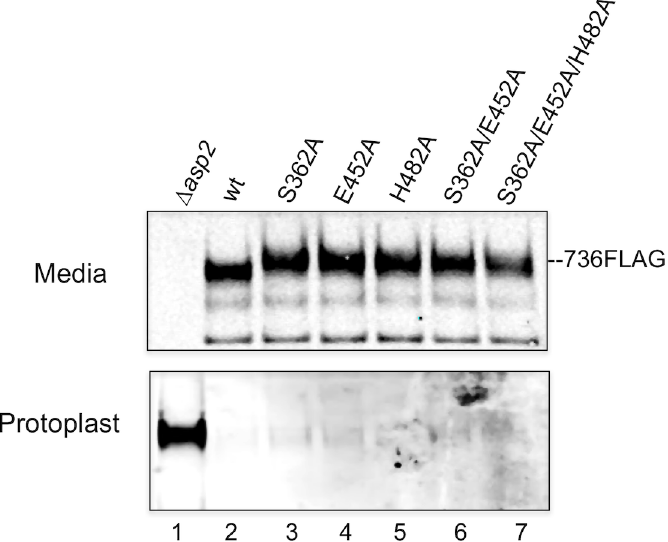
Fig 5. Effects of mutating the Asp2 catalytic triad upon the export of GspB736flag. Western blot analysisof Asp2-dependentexport of GspB736flagby S . gordonii Δ asp2 strain PS1244(lane 1), parental strain PS1225(lane 2) and derivative strains harboringthe designatedalaninesubstitution within the catalytic triad of Asp2, PS3539(lane 3), PS3551(lanes 4), PS3552(lane 5), PS3553(lane 6), PS3554(lane 7). Culture media (M) and protoplasts (P) were collectedfrom exponentially growingstrains. Proteinswere separated by SDS-PAGE and analyzedby Western blotting, using anti-FLAG antibodyto detect GspB736flag. The data shown is representativeof at least three different genetic transformants for each